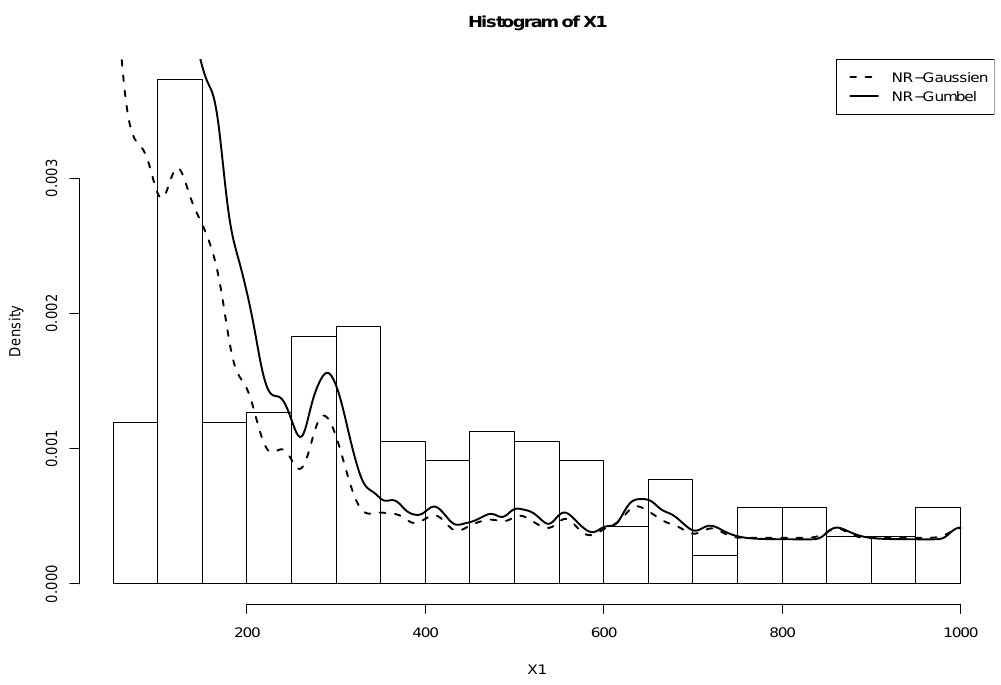
Figure 4: Qualitative comparison between Gumbel and Gaussian kernel estimators. Here we consider the caniapiscau dataset of the package FlowScreen